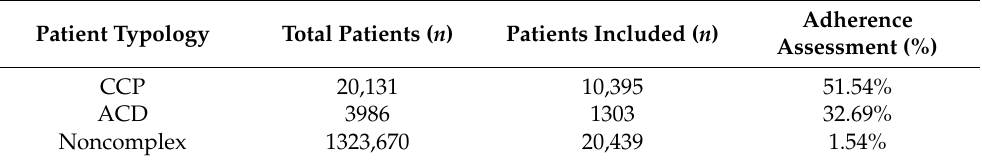
Table 2. Distribution of recorded adherence assessments based on patient